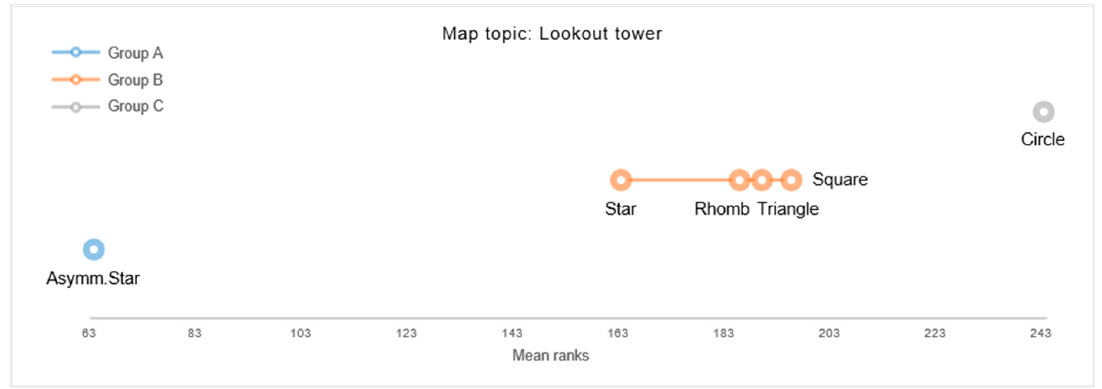
Figure 11. Map #7: Results of multiple pairwise comparisons, indicating groups of (dis)similar symbol-content congruence.